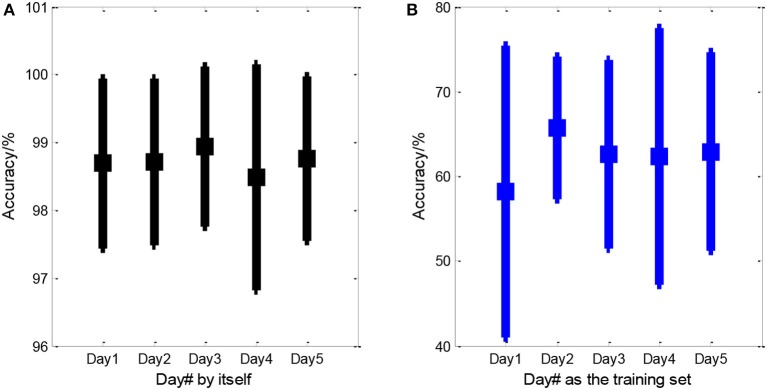
Averaged accuracies of within- and standard cross-day emotion classification. (A) Within-day classification and (B) the standard cross-day scenario that accounted for inter-day EEG variability. The spot indicates the mean value and the line is the standard deviation. In (A), Day# presented the day that training samples and testing samples were both from. In (B), Day# indicated the training day, and remaining 4 days were hold as the testing days.